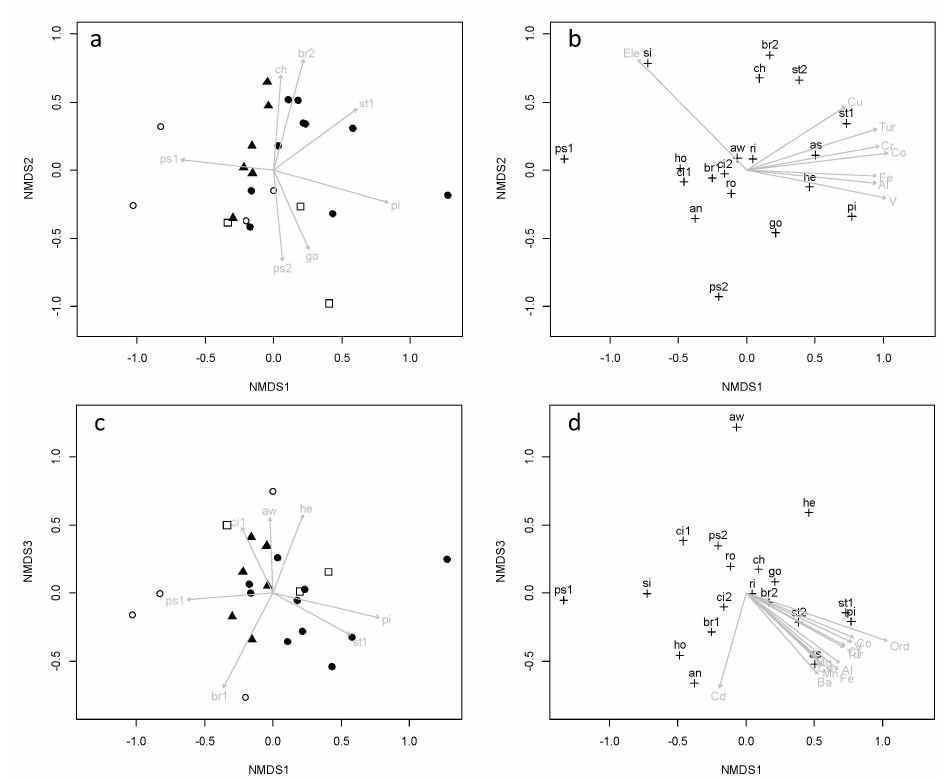
Figure 6. Results of NMDS of relative abundances of fish species at the study sites (stress =